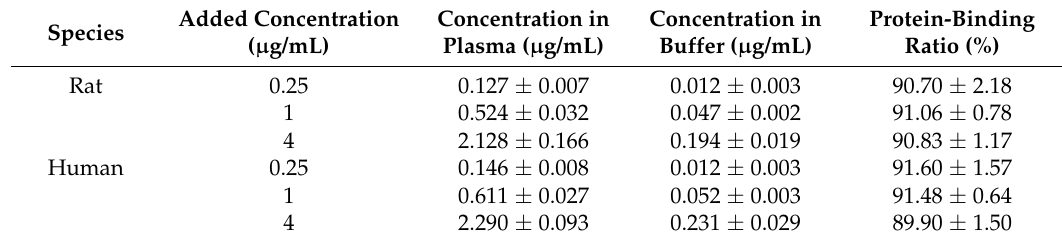
Table 3. Determination of the protein binding ratio of methyl 3-amino-6-methoxythieno [2,3-b] quinolone-2- carboxylate (PU-48) in rat and human plasma ( n =